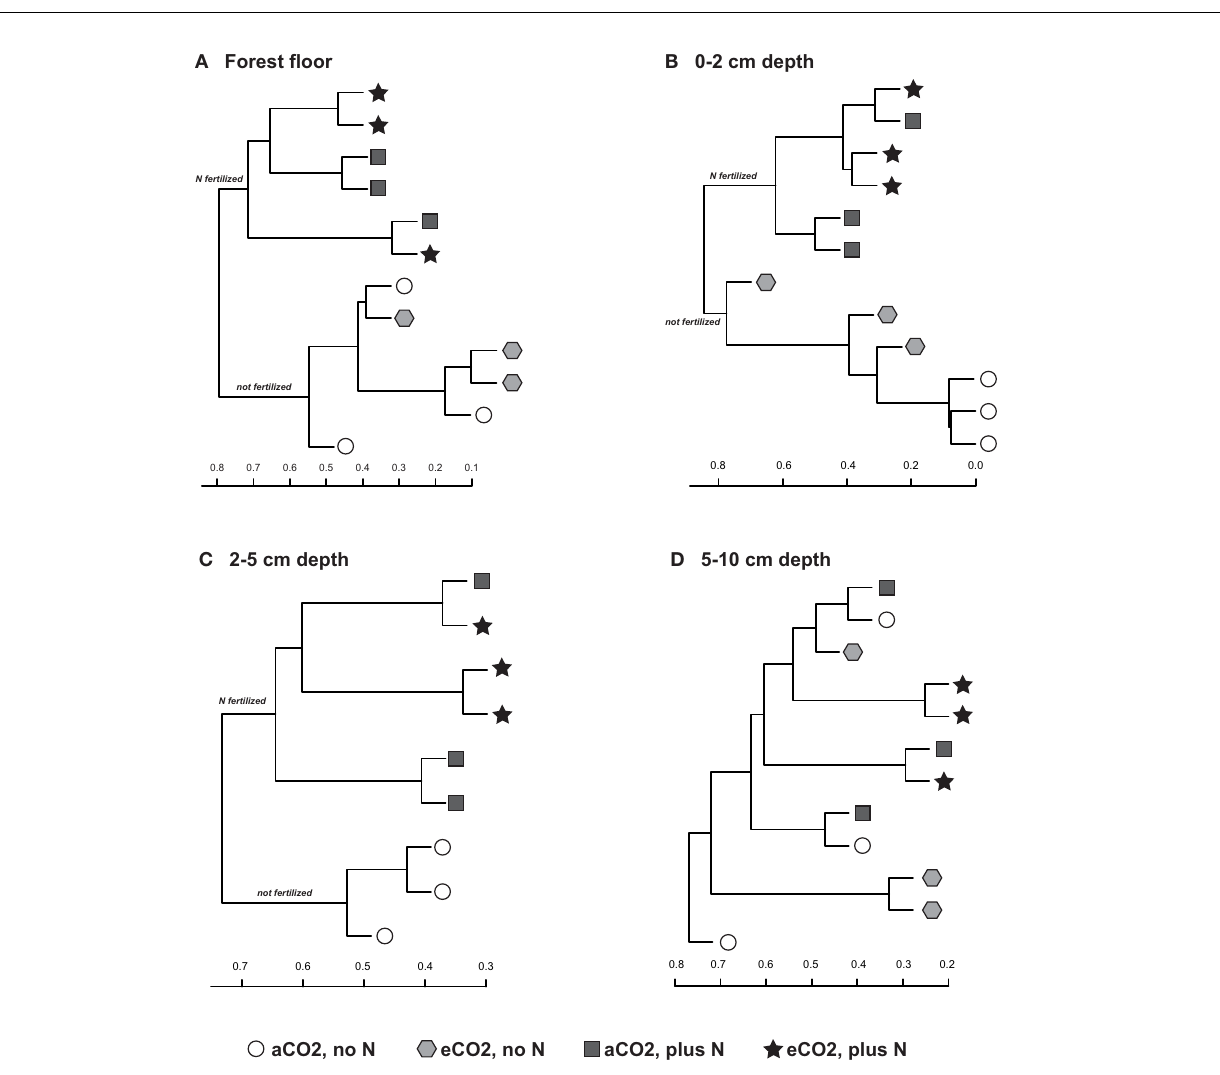
Frontiers in Microbiology |Terrestrial